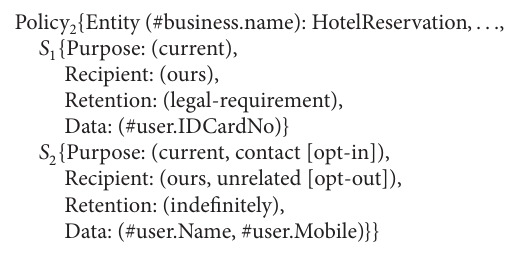
Algorithm 8: P3P policies of FlightBooking service, HotelReserva- tion service, and Payment service (P3P policy of HotelReservation service).